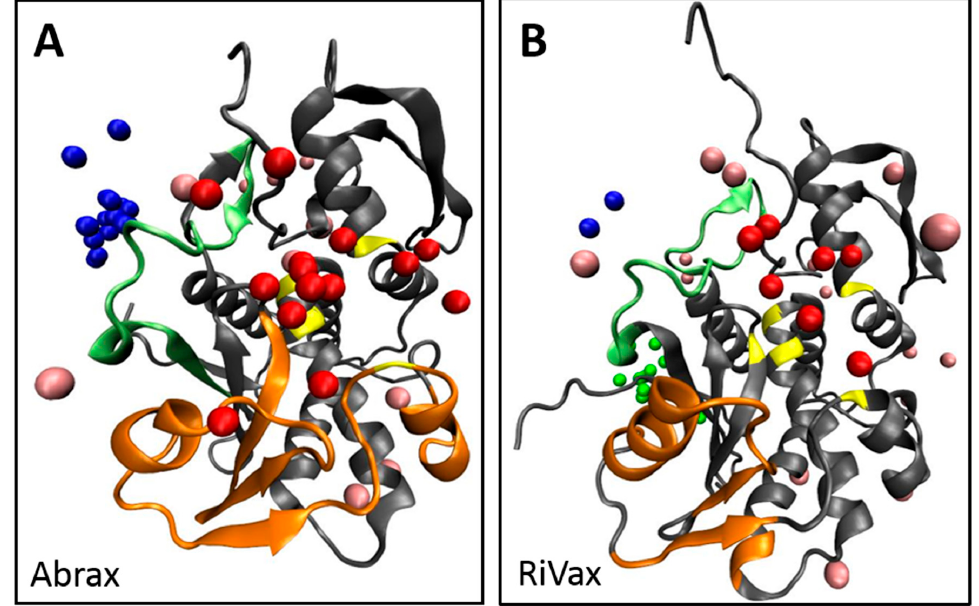
Figure 3. Structures of abrax ( A ) and RiVax ( B ), both shown in gray, with known epitope binding locations mapped in orange and the known solvent exposed loop, described by Compton et al., mapped in light green. Active site residues are shown in yellow. Top 10 decoys for Tier 1 peptide binders are colored by location to show location 1 (blue), location 2 (red), location 3 (green) and other binding locations (pink).